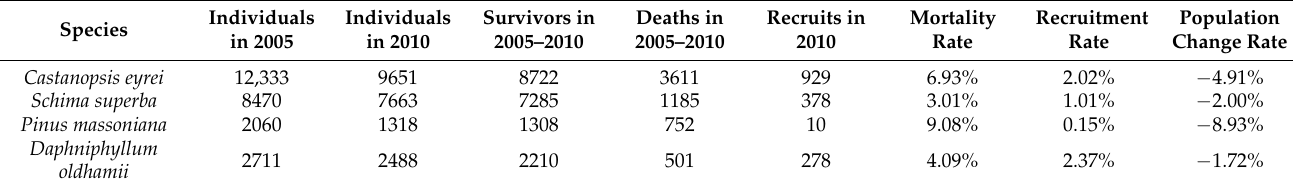
Figure 2. Diameter structure dynamics, recruitment, upgrades, and mortality of the four canopy dominant populations from 2005 to 2010. ( a ) Diameter structure dynamics of C. eyrei ; ( b ) recruitment, upgrades, and mortality of C. eyrei ; ( c ) diameter structure dynamics of S. superba ; ( d ) recruitment, upgrades, and mortality of S. superba ; ( e ) diameter structure dynamics of P. massoniana ; ( f ) recruitment, upgrades, and mortality of P. massoniana ; ( g ) diameter structure dynamics of D. oldhamii ; ( h ) recruitment, upgrades, and mortality of D. oldhamii . Table 2. Population dynamics of canopy layer dominant species from 2005 to 2010.